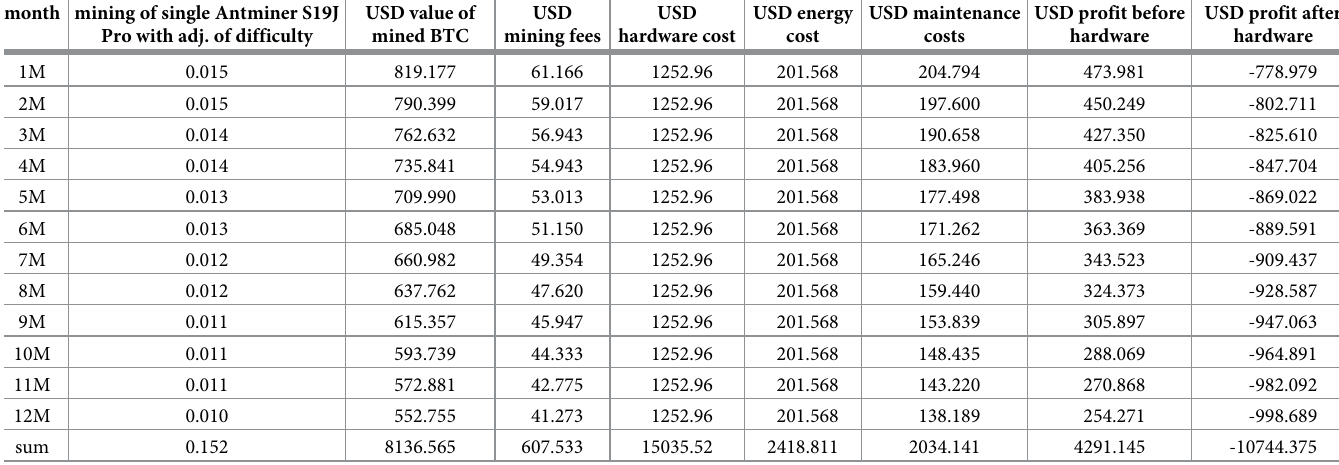
Table 3. Monthly USD profitability of mining of single Antminer S19J Pro (104 TH/s) with adjustment of difficulty based on 1Y avg monthly BTC hash rate change. month mining of single Antminer S19J Pro with adj. of